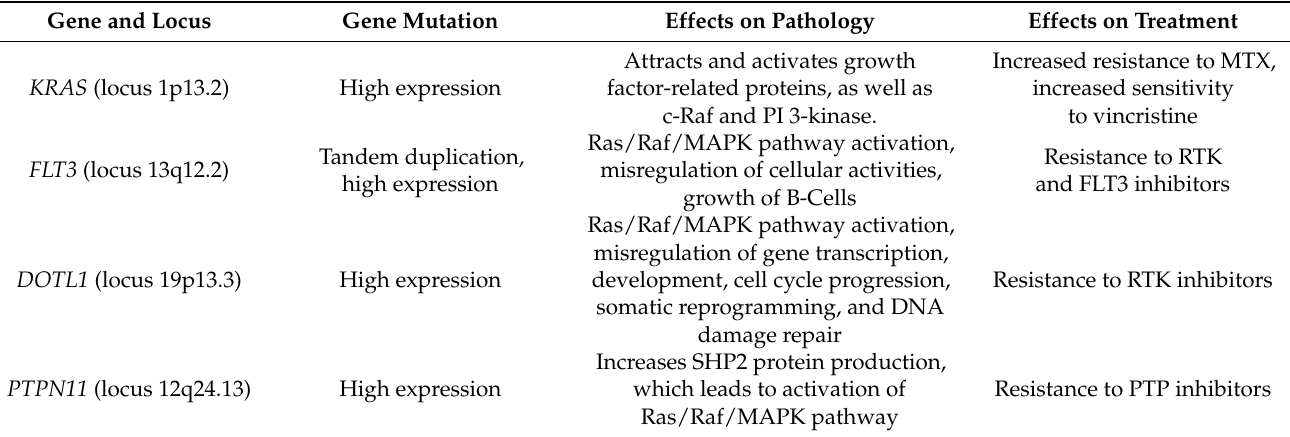
Table 4. Characteristics of genes occurring together with hyperdiploidy responsible for resistance to applied